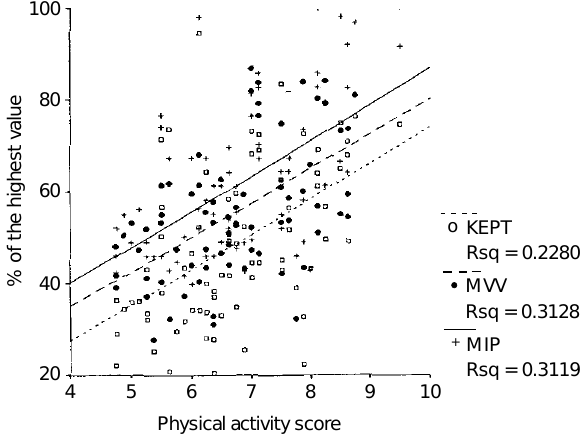
Figure 3 - Positive correlation between physical activity score (6) and some indexes of muscular strength such as peripheral (knee extensor peak torque, KEPT) and respiratory (maximal voluntary ventilation, MVV and maximal inspiratory pressure, MIP) strength. P<0.001 for all corre- lations.